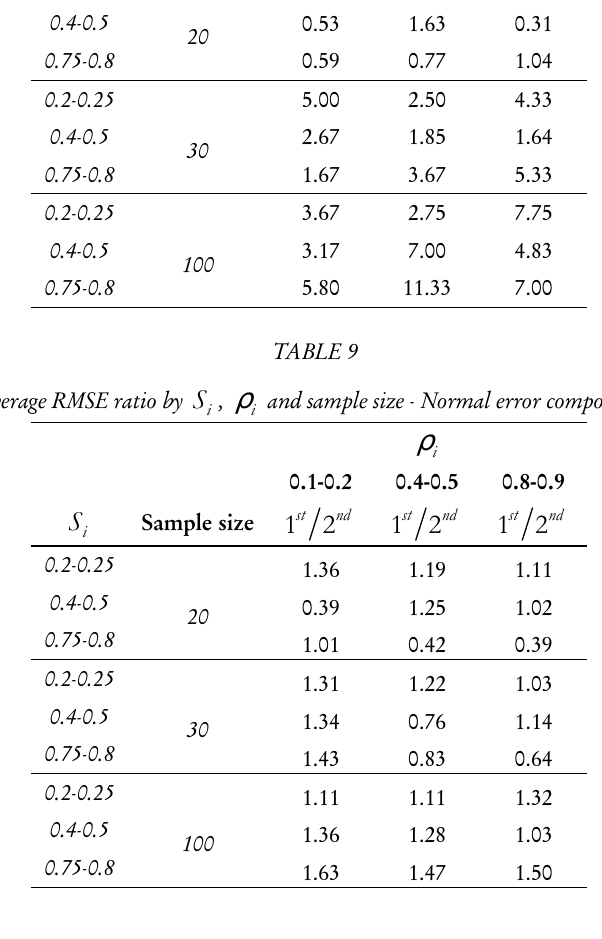
Average bias ratio by i S ,